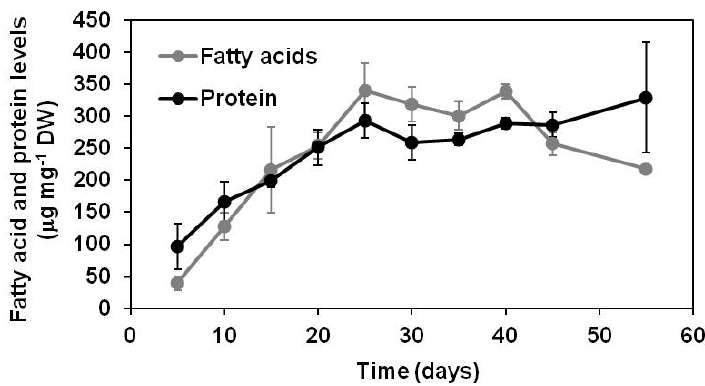
Figure 1. Changes in fatty acid and protein levels in developing soybean embryos.